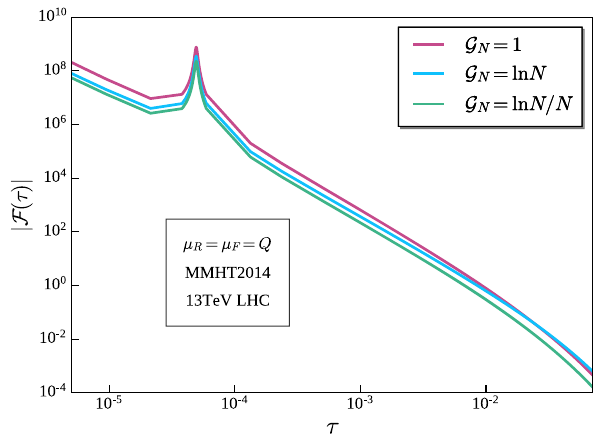
Fig. 1 Variation of SV and NSV functions with respect to τ = Q 2 / S